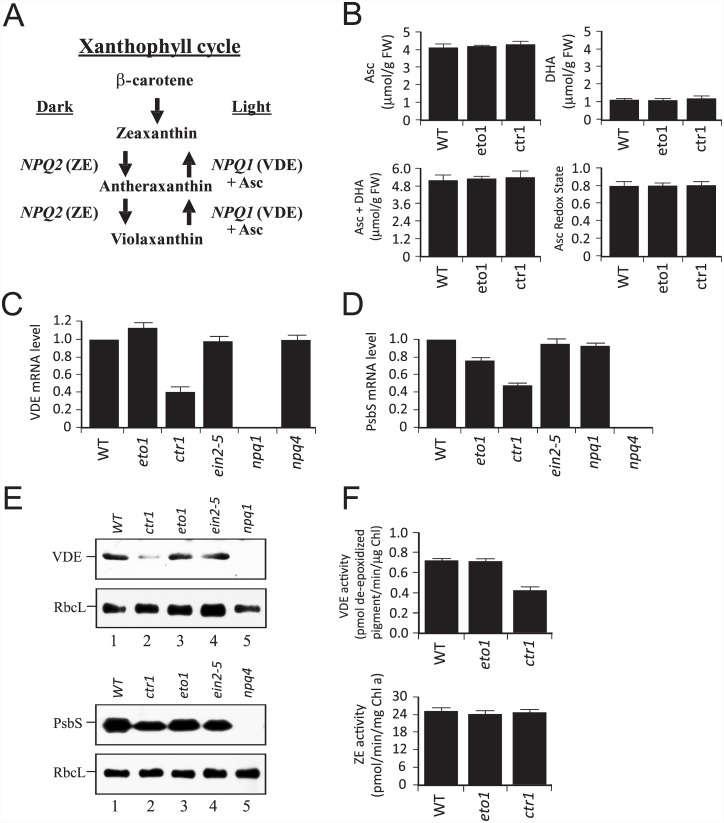
Increased ethylene signaling represses VDE and PsbS expression.(A) The xanthophyll cycle. NPQ1 encodes violaxanthin de-epoxidase (VDE) whereas NPQ2 encodes zeaxanthin epoxidase (ZE). (B) The pool sizes for Asc, DHA, total ascorbate (i.e., Asc + DHA), and the Asc redox state were measured in leaves of 4 week-old eto1-1, ctr1-3, and WT plants. (C) qPCR analysis of NPQ1 mRNA in leaves of 3 week-old plants. (D) qPCR analysis of PsbS mRNA in leaves of 3 week-old plants. (E) VDE and PsbS protein levels were measured by Western analysis in leaves of 3 week-old plants. Western analysis of the large subunit of Rubisco served as a control. Loading was on an equal chlorophyll basis. (F) VDE and ZE enzyme activity were measured in leaves of 3 week-old eto1-1, ctr1-3, and WT plants. The data reported are the average and standard deviation of three biological replicates.